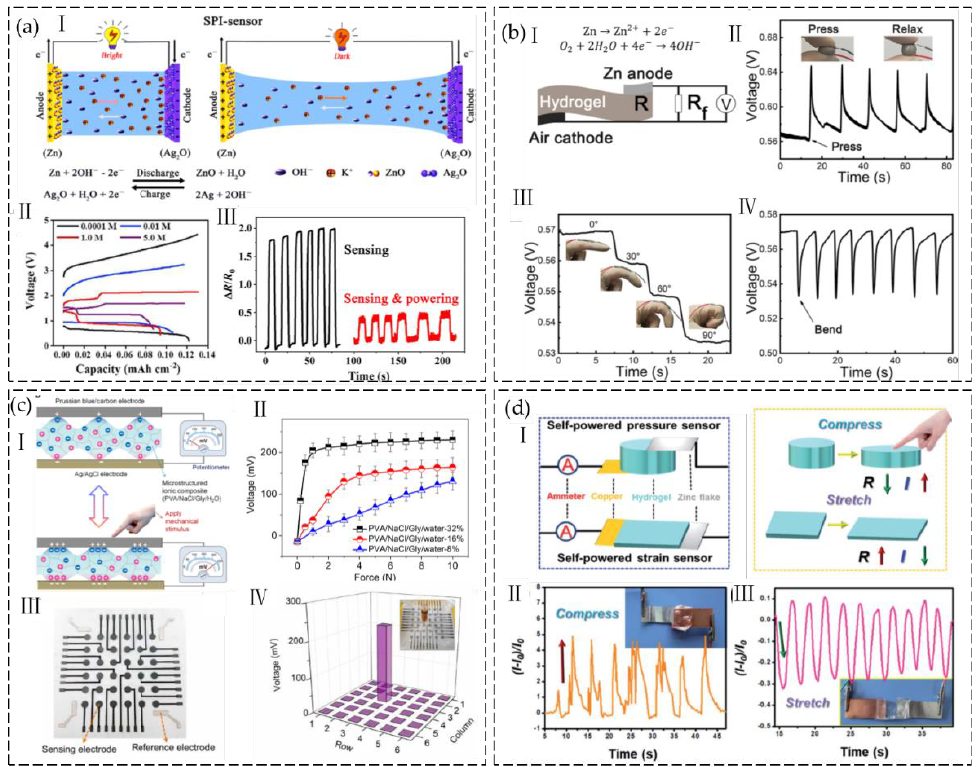
Figure 13. ( a ) Ⅰ . Self-powered strain-sensing mechanism of the self-powered ionic hydrogel-based Figure 13. ( a ) I. Self-powered strain-sensing mechanism of the self-powered ionic